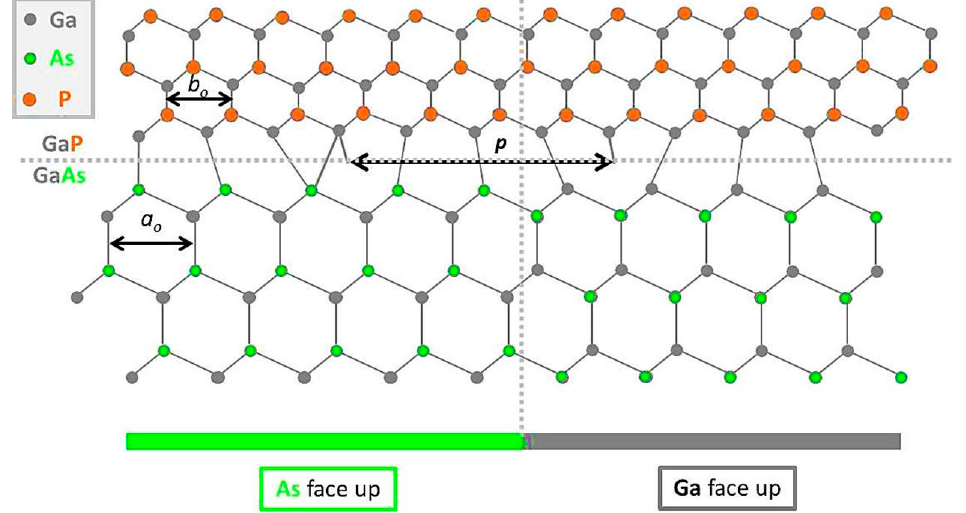
Figure 34. Heteroepitaxy of OPGaP on OPGaAs templates. For simplicity the pseudomorphous growth is not presented on the image [4]. ((Reproduced from [4] with some modifications with the permission of World Scientific).